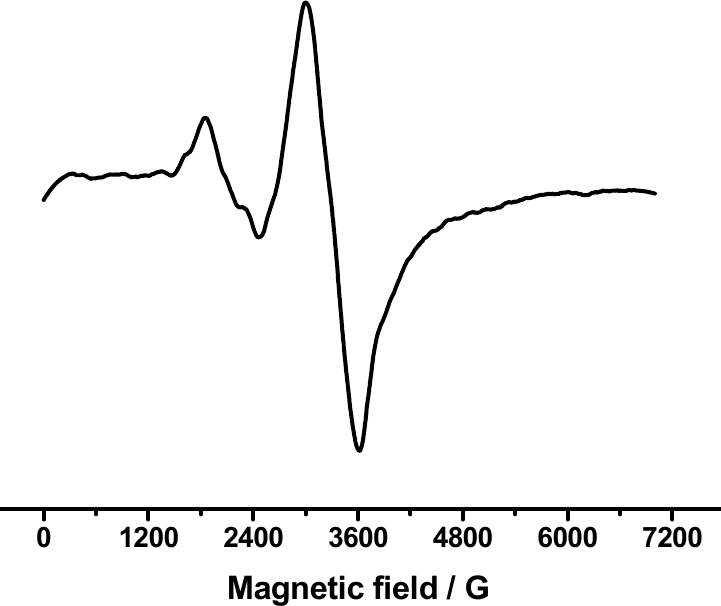
Figure 11. Semi-derivative of CV (up to 2500mV) for oxidation of CP 2 . Conditions: CPE [graphite + ionic liquid + CP 2 ] in 2 mL CH 3 CN (0.1 M Bu 4 NBF 4 ).